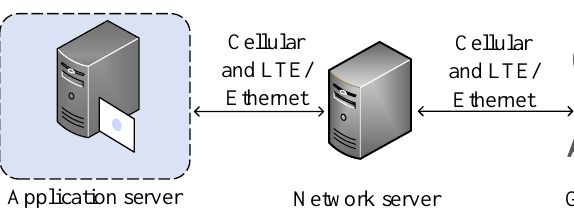
Figure 1. Internet of Things technologies.